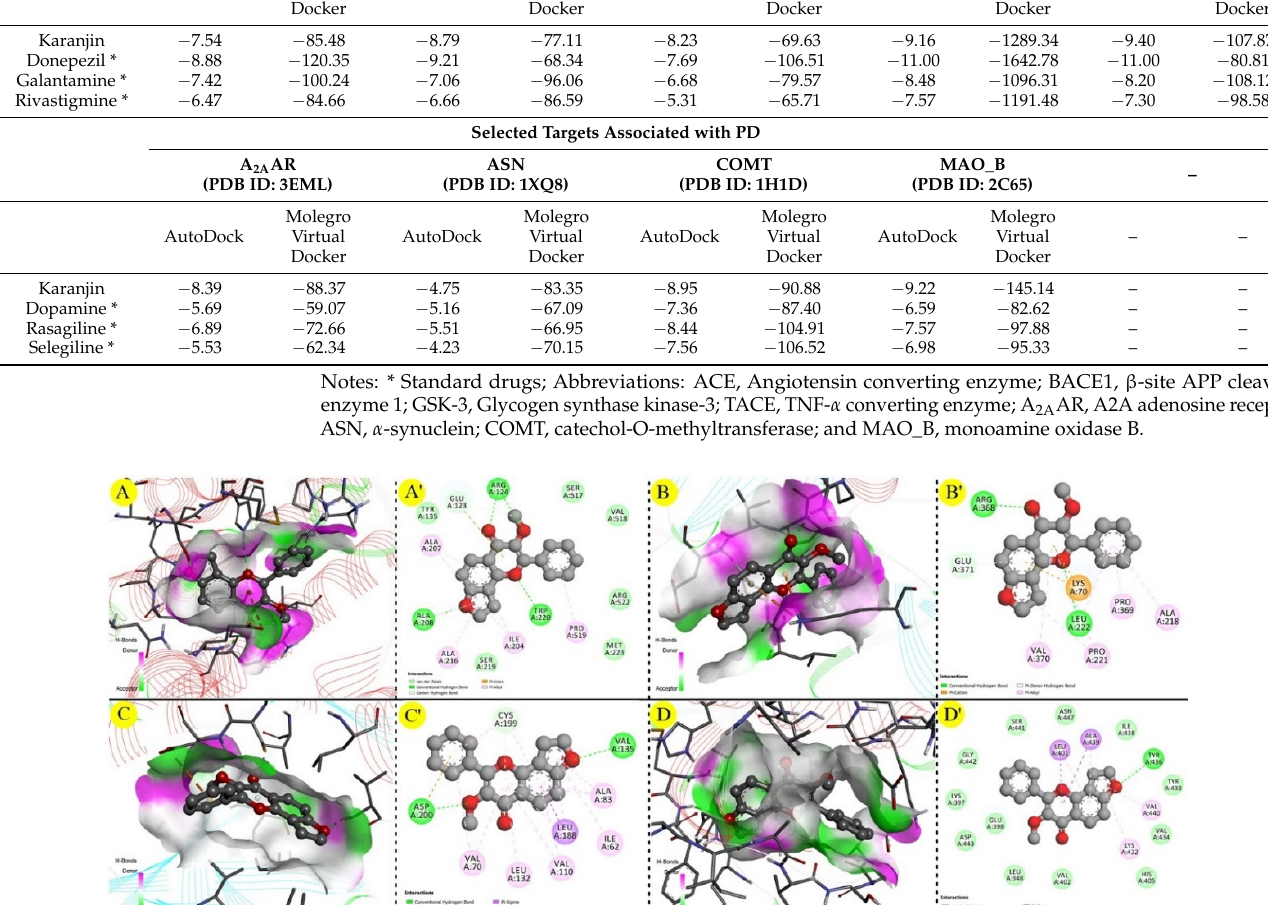
Table 2. Molecular docking score (kcal/mol) of karanjin with three standard drugs against four dif- ferent human targets proteins associated with AD and PD.